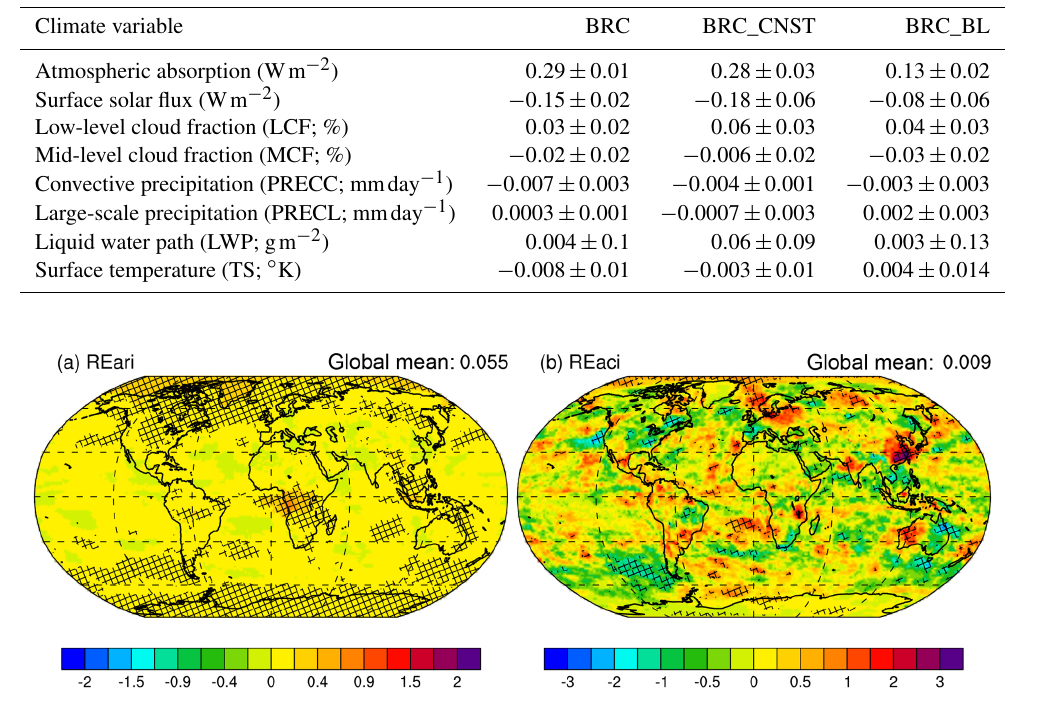
Figure 13. Same as Fig. 6 but for the BRC_BL model run. Hatching indicates regions where the change over the ensemble years is significant to the 0.05 (REari) and 0.1 (REaci) levels.